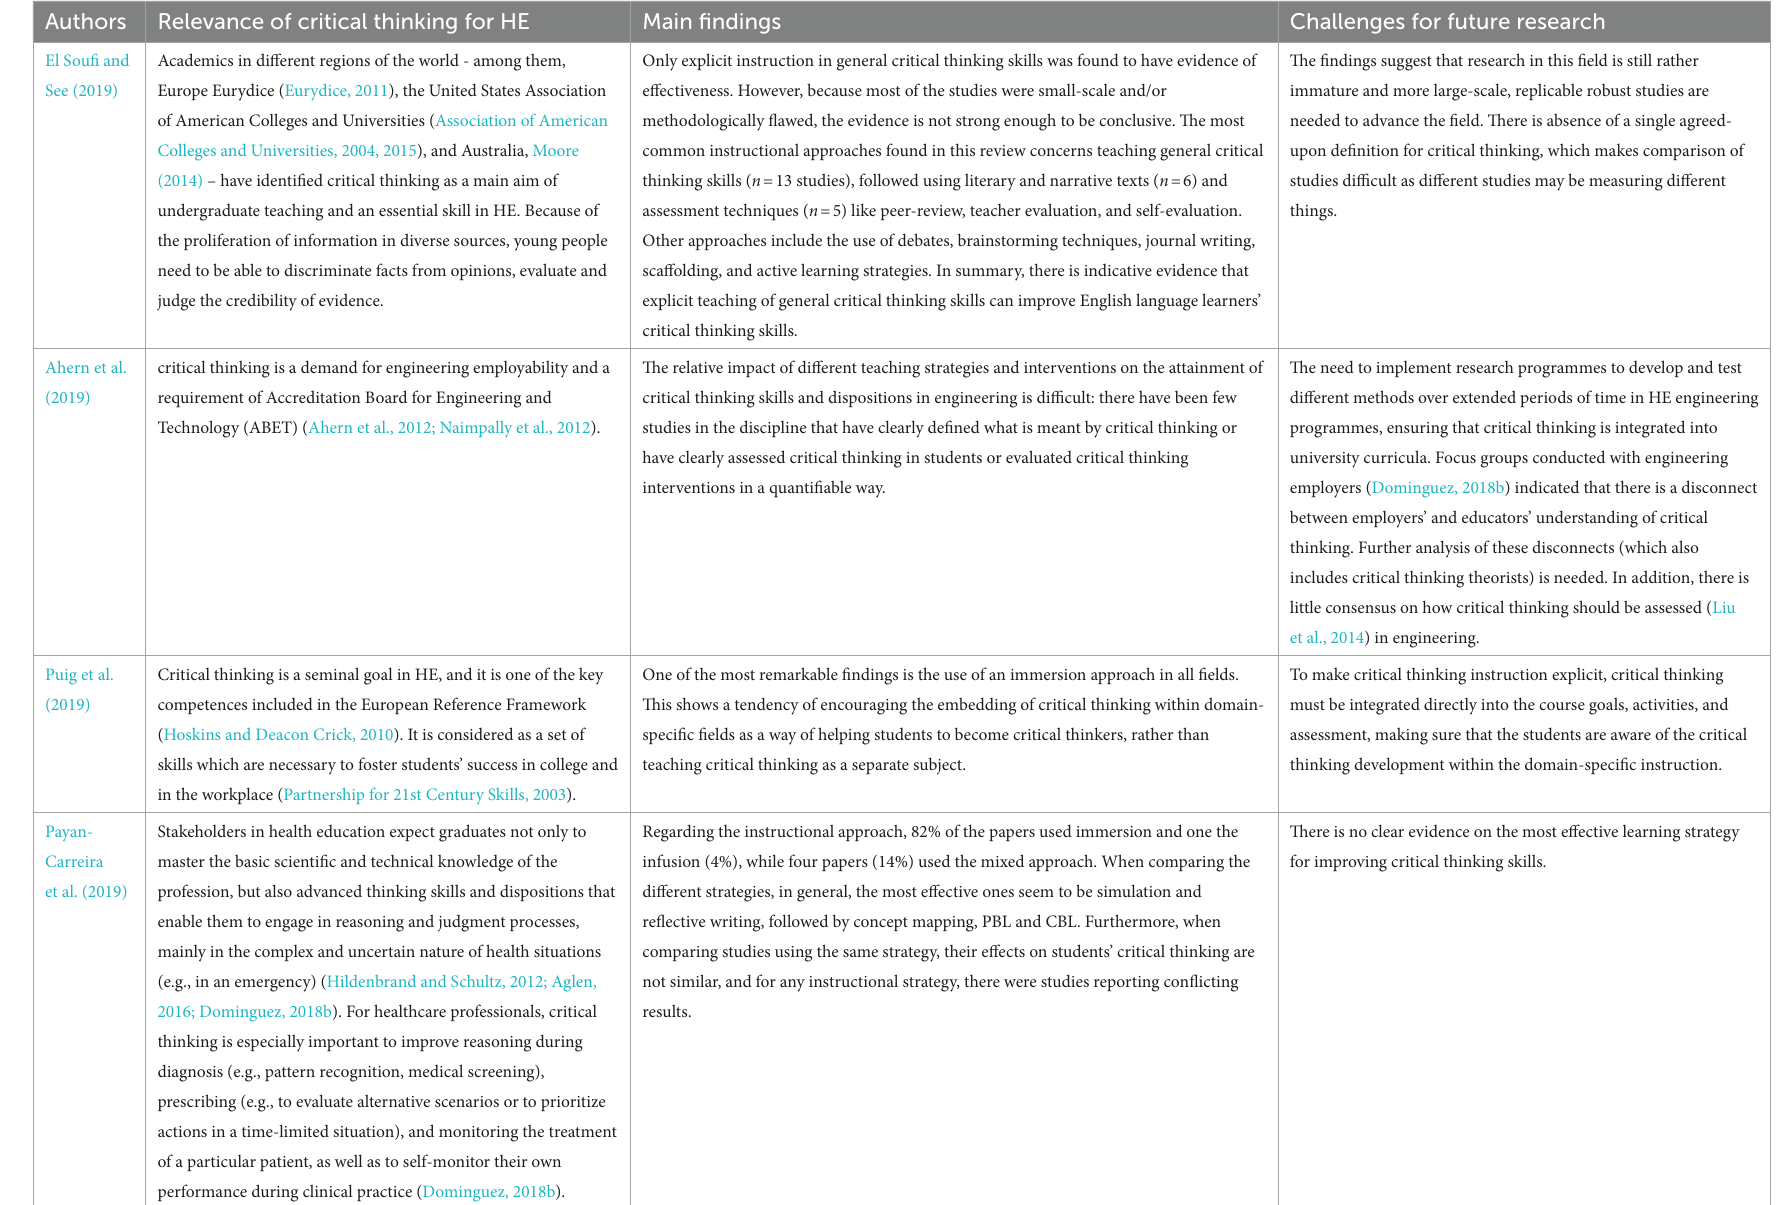
TABLE 5 Summary of the relevance of critical thinking to HE, key findings, and challenges for future research of each of the reviews.